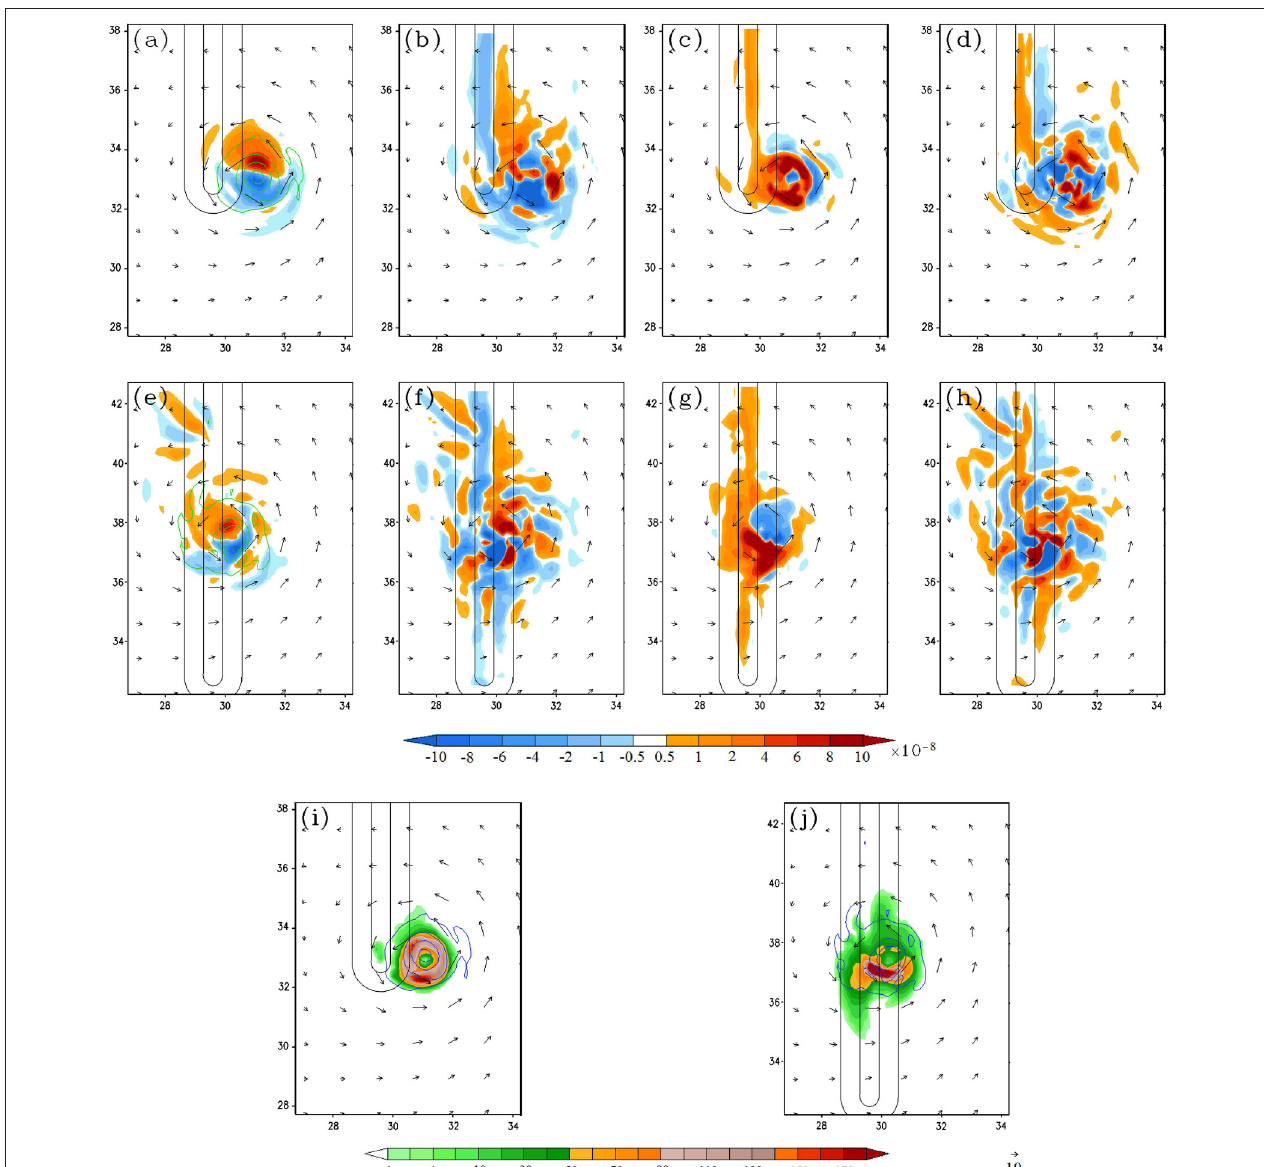
FIGURE 14 | (Track B) The vorticity budge analysis for Track B: (A–D) are the 950–500 hPa layer-averaged vorticity tendency (VT), horizontal vorticity advection, relative vorticity stretching, and residual term, respectively, at 150h. (E–H) Are the same as (A–D) respectively, but at 204h. (I,J) Are the 3h accumulated rainfall at 150h and 204h (in mm/3 h), respectively. The units of the coordinates in the x and y directions are 100 km. The vertical vorticity field is depicted by contours (0.0001, 0.0005, 0.001, 0.002, 0.003 s − 1 ) in (A) .